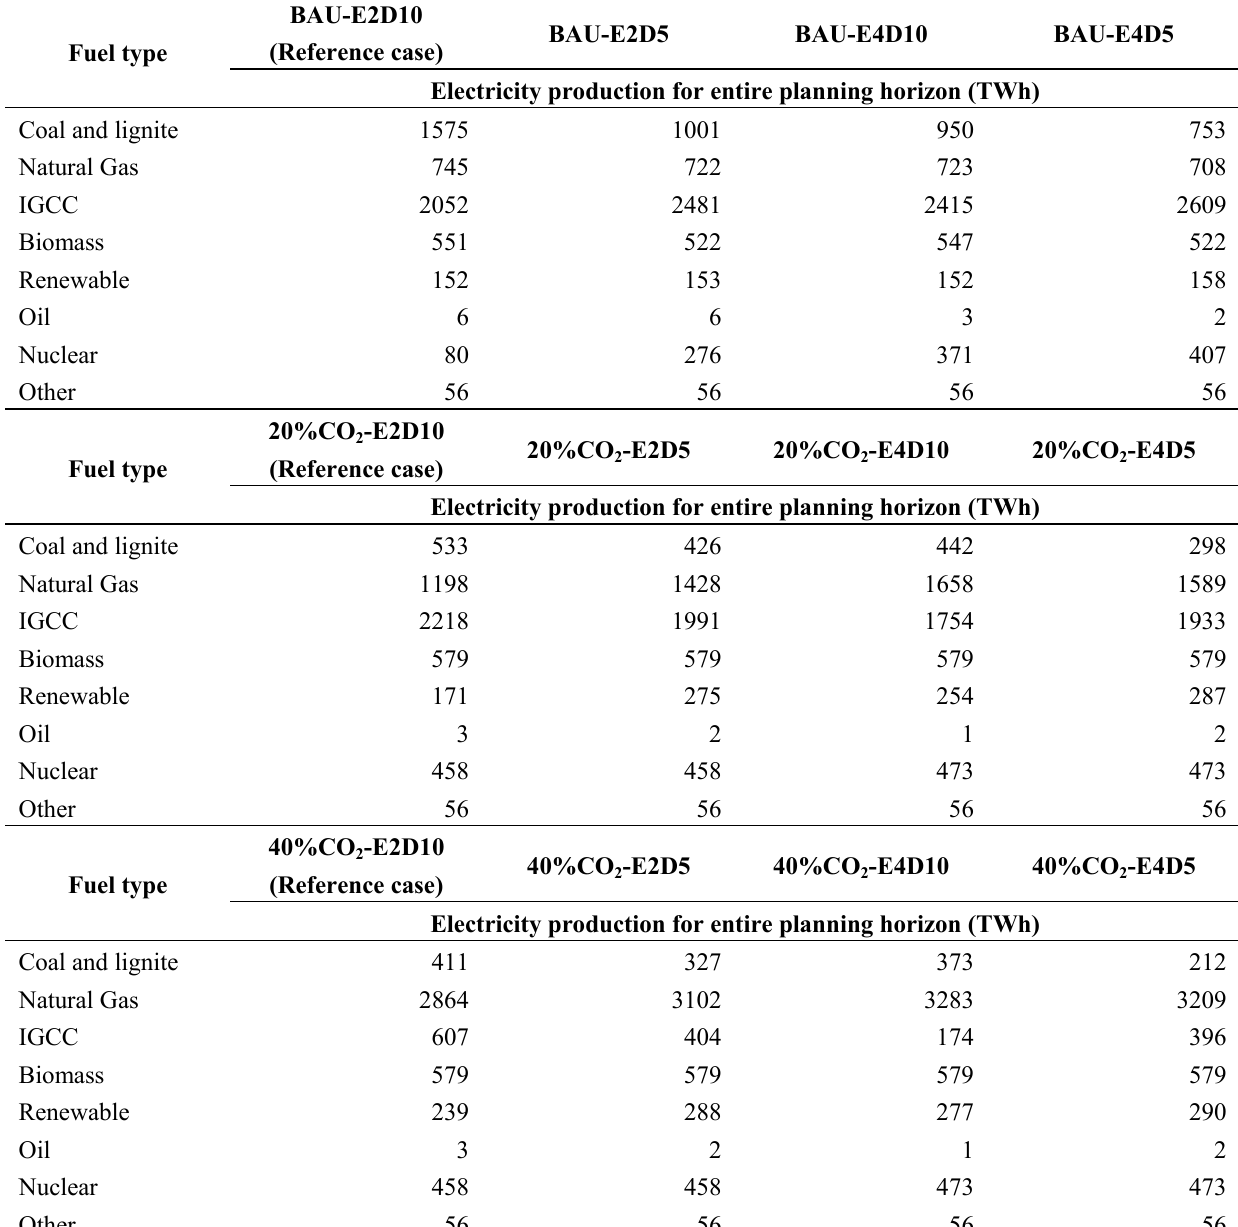
Table 7. Comparative generation mix for the sensitivity